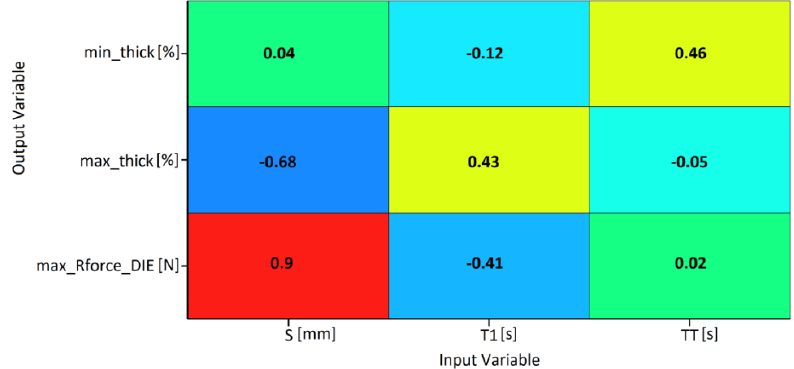
Figure 27 - Design explored with MIGA for the blank1 plan. 4. Model Validation In order to test the optimization model reliability, numerical analysis runs were performed for the combinations as reported in Tables 7 and 9, in accordance with parameter combinations relating to the optimal solution suggested by the optimization procedure. The punch-displacement input curve definition is reported for the two “optimal runs” in Figure 28. The results for the two runs are shown below. In particular, Figure 29 reports the trend of die reaction force curves, both for the blank0 and blank1 cases. It is evident how, when a stepwise happens, it is possible to detect a reaction force reduction (Figures 28 and 29). For both cases there is a slope variation of the reaction force in the coining phase. Figure 28. Displacement vs time comparison for the optimal combination (according to the regression model) for blank0 and blank1 plan.